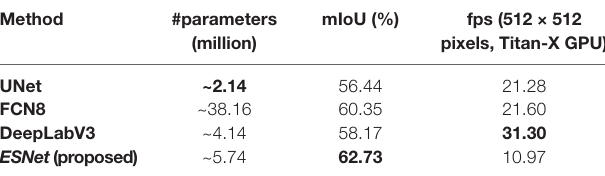
TABLE 1 | Comparison of different networks on the paddy line